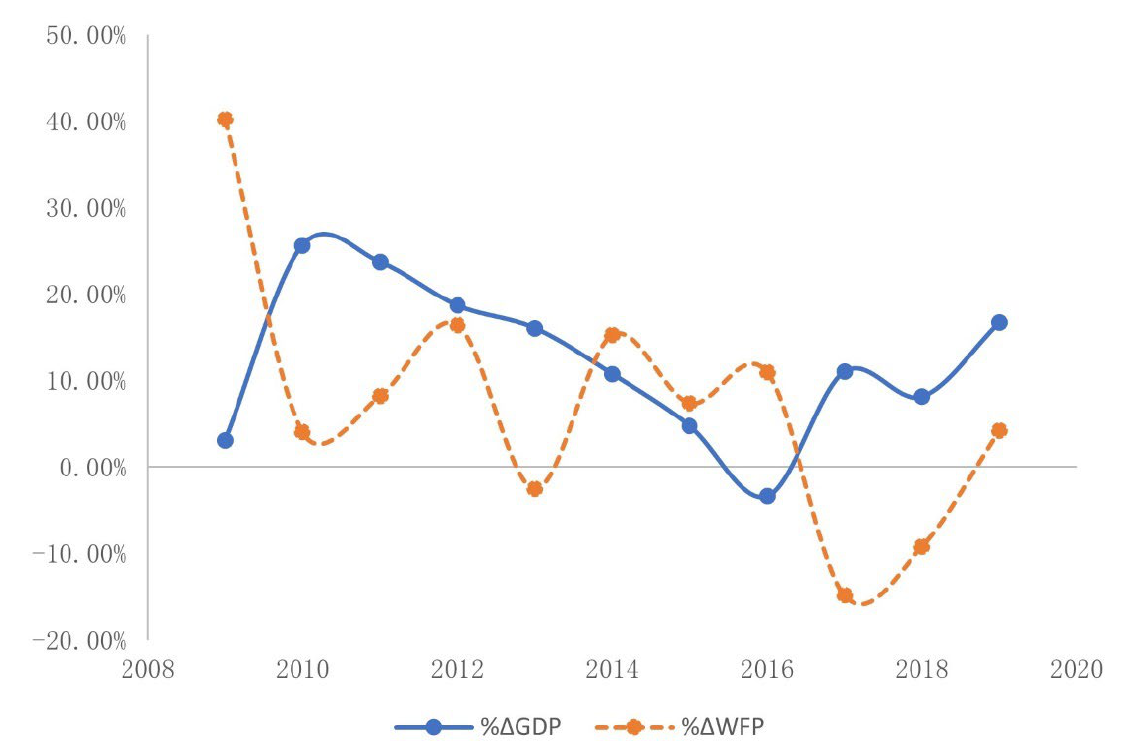
Figure 8. 2008–2019 Coordination relationship between economic growth and water resources utilization in Tarim River basin. Data source: According to the statistical yearbook of Xinjiang.